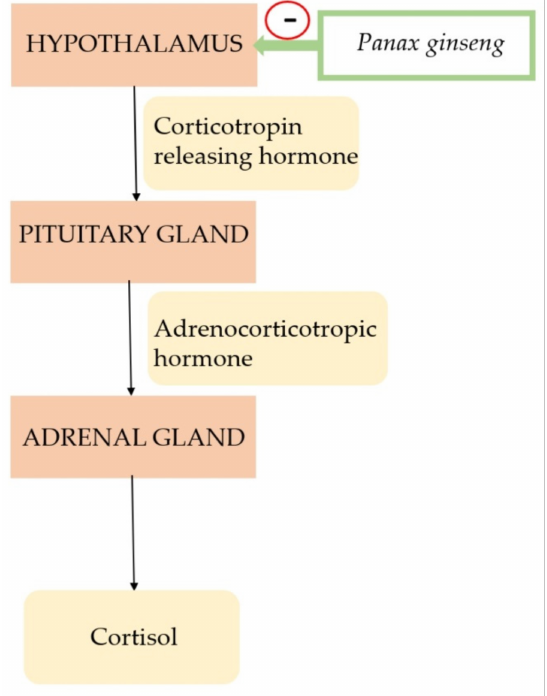
Figure 2. Mechanism of action of Panax ginseng